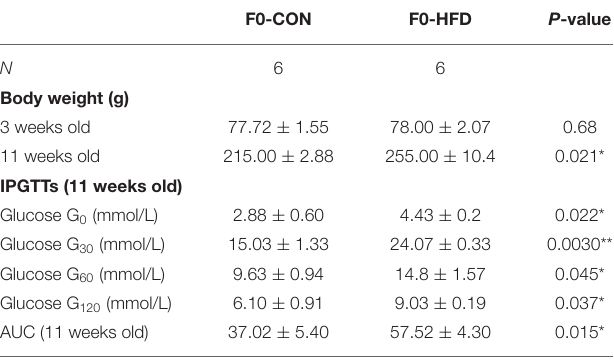
TABLE 1 | Biochemical parameters of F0 female models. F0-CON